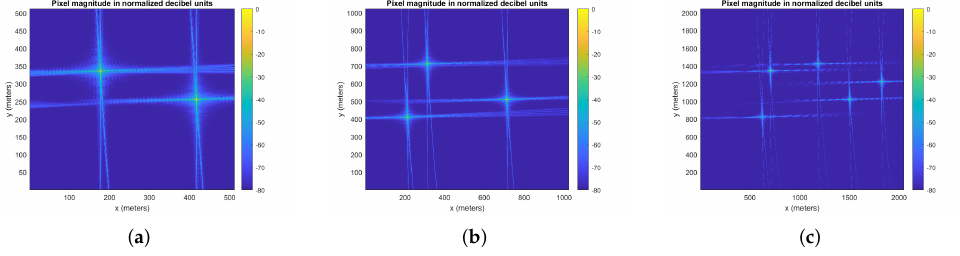
Figure 14. Images generated using the backprojection algorithm with the PERFECT dataset (sizes small, medium and large). ( a ) Perfect dataset image (size small) generated using the back- projection algorithm. ( b ) Perfect dataset image (size medium) generated using the backprojection algorithm. ( c ) Perfect dataset image (size large) generated using the backprojection